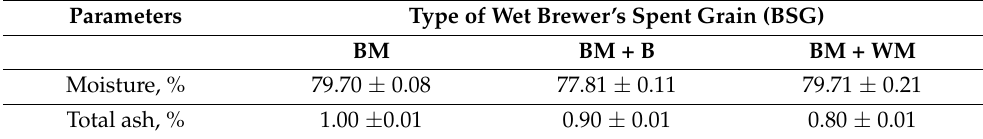
Table 1. Content of components in wet spent grain.